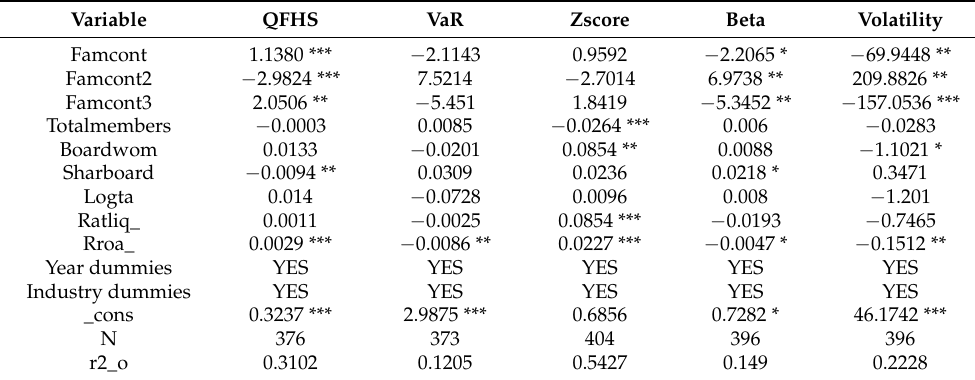
Table 12. Models considering corporate governance